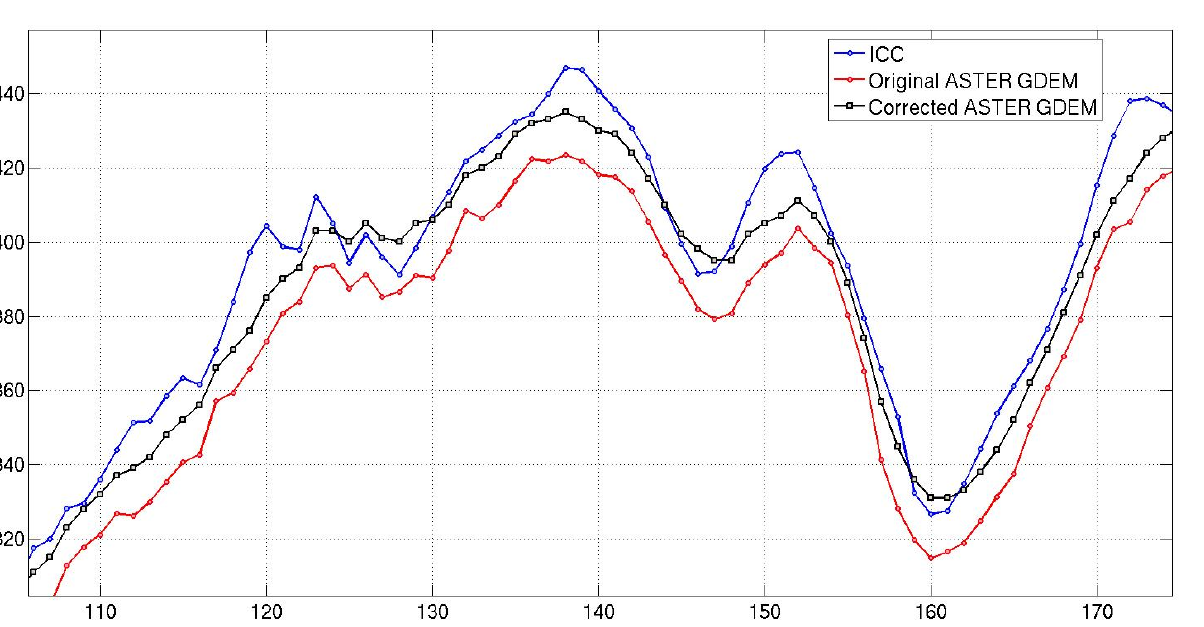
Figure 18. Profiles compare the location of the ASTER GDEM pixels before (red) and after (black) correction as well as the ICC ground truth